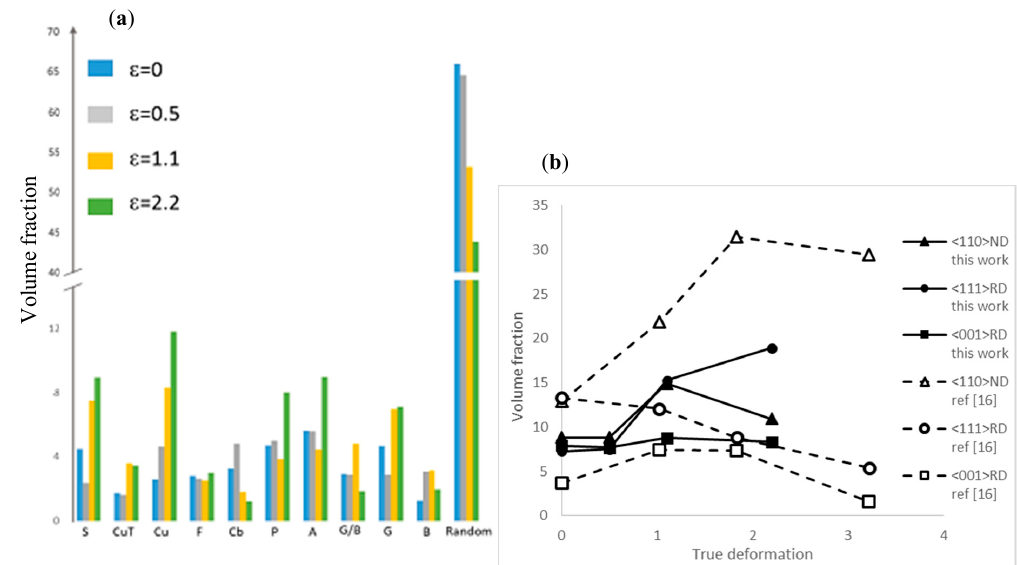
Figure 7. ( a ) Volume fraction of the main principal different detected texture component and ( b ) fiber- texture comparison between groove cold rolling (this work) and conventional cold rolling (ref.